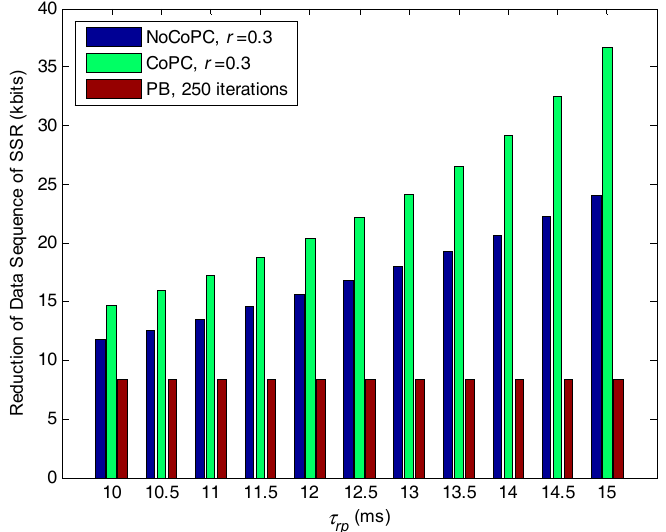
Figure 12. Reduction of data sequence of spectrum sensing resultsfor of selected spectrum sensor nodes vs. the slot τ rp ( r = 0.3, l = 250 iterations). NoCoPC: noncooperative power control; CoPC: cooperative power control; PB: power balancing.